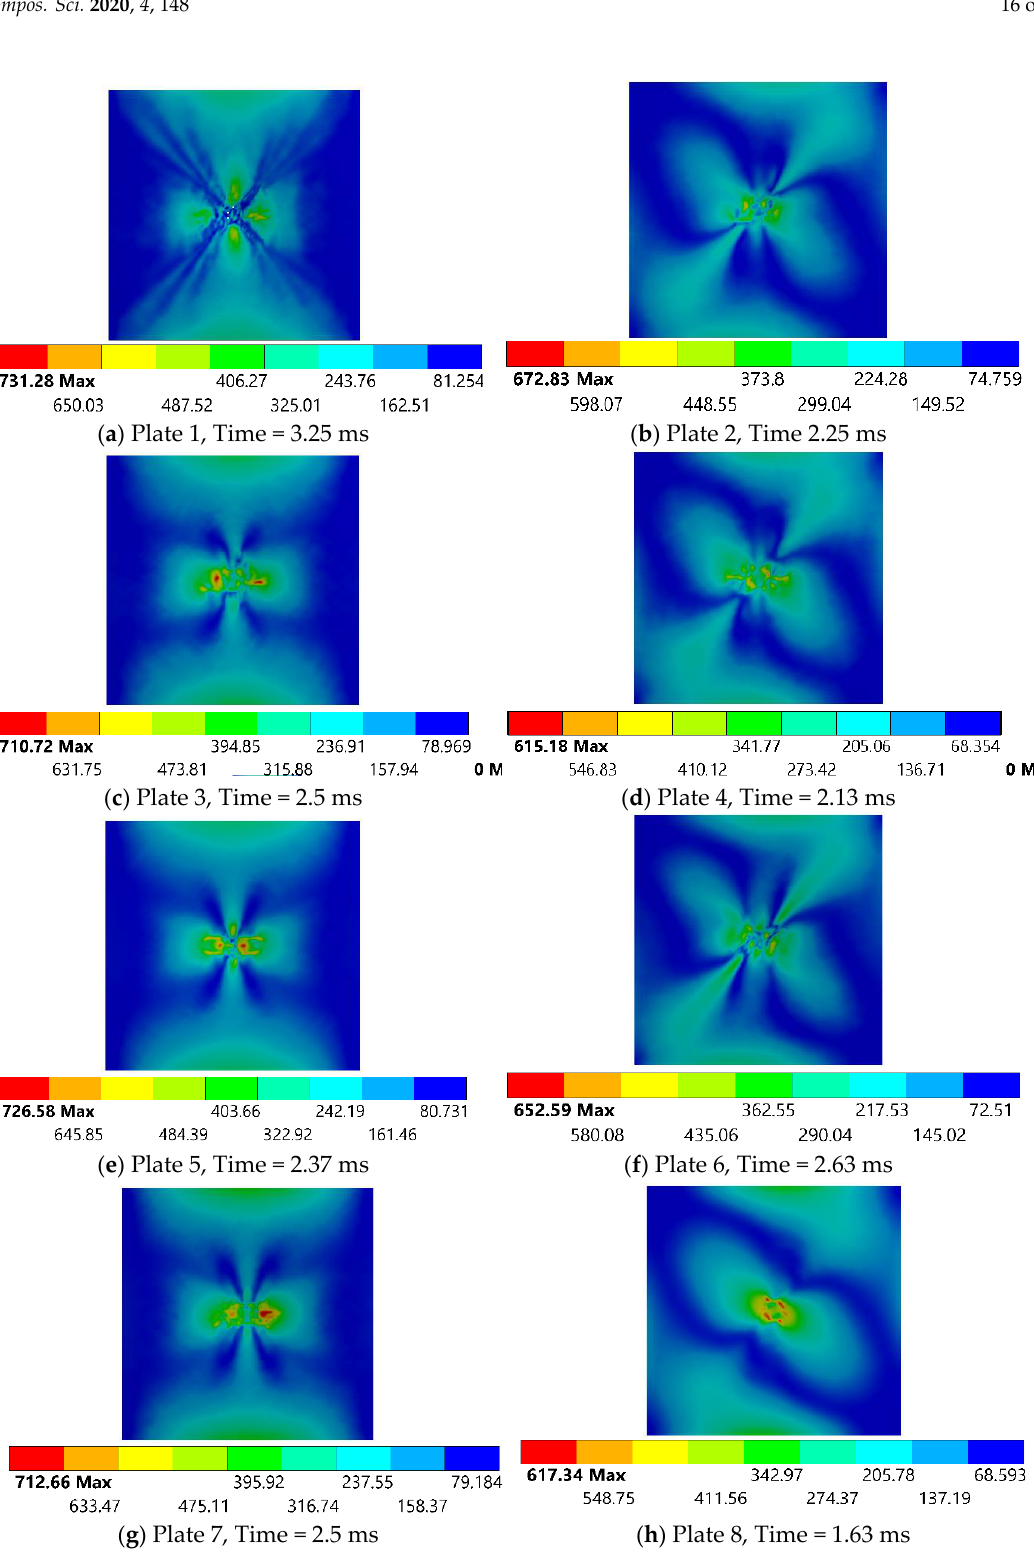
Figure 14. Von Mises stress distribution for all plate designs.